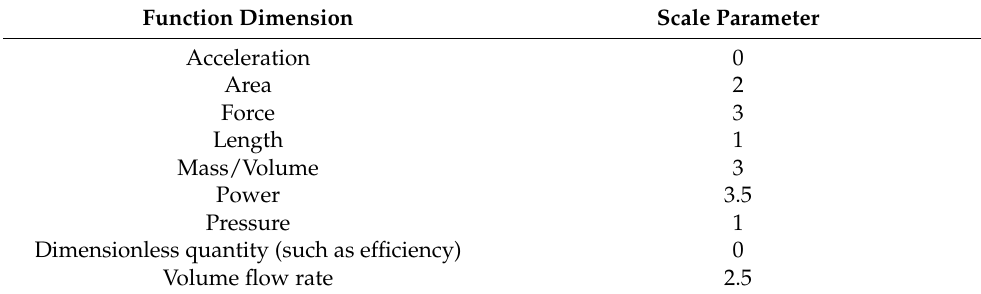
Table 1. Scale parameter of the Froude law similarity adapted from [65,86]. Function Dimension Scale Parameter Acceleration 0 Area 2 Force 3 Length 1 Mass/Volume 3 Power 3.5 Pressure 1 Dimensionless quantity (such as efficiency) 0 Volume flow rate